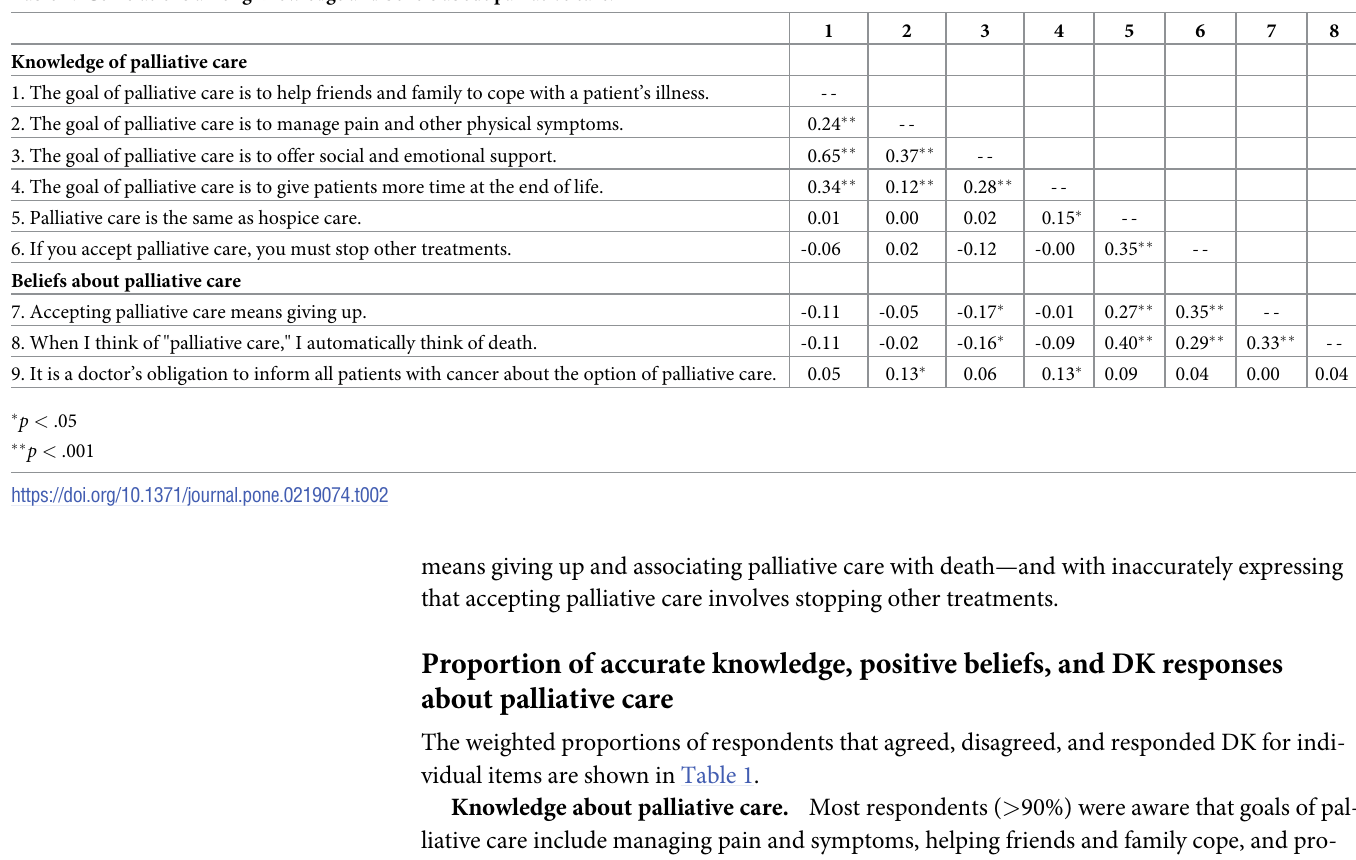
Table 2. Correlations among knowledge and beliefs about palliative